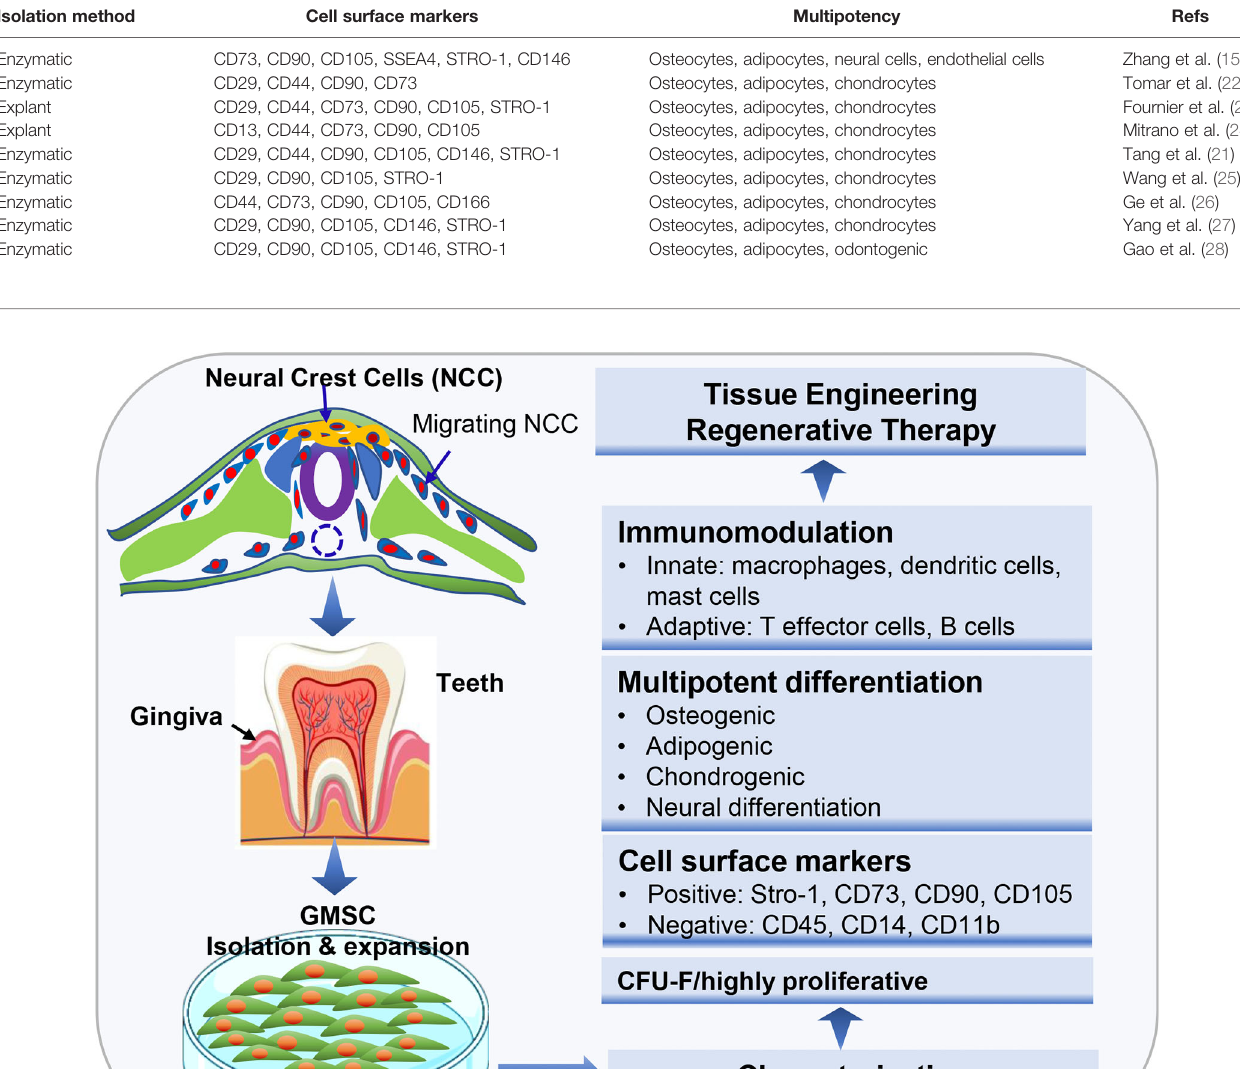
TABLE 1 | Isolation and characterization of human